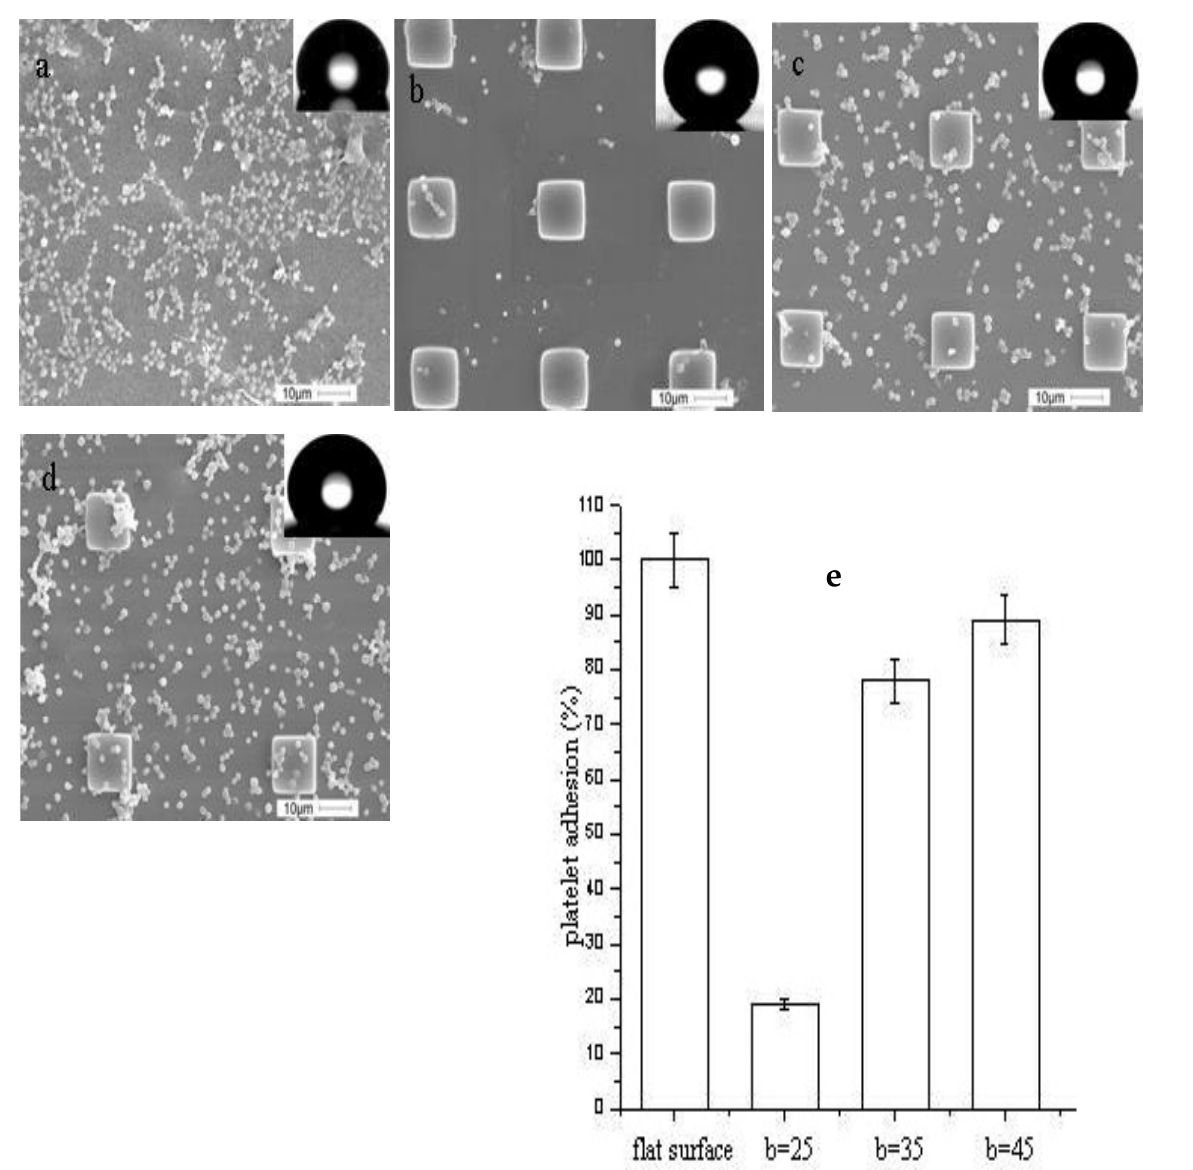
Figure 8. SEM of platelets adhesion to ( a ) a flat substrate; ( b – d ) superhydrophobic surfaces with micro-pillars; ( e ) platelet adhesion on different surfaces along with percentage of adsorption onto a flat surface. Width a =10 μ m, height h = 5 μ m, with spacings b = 25 μ m, 35 μ m, and 45 μ m, respectively, reported by Zhou, M., et al. [91].